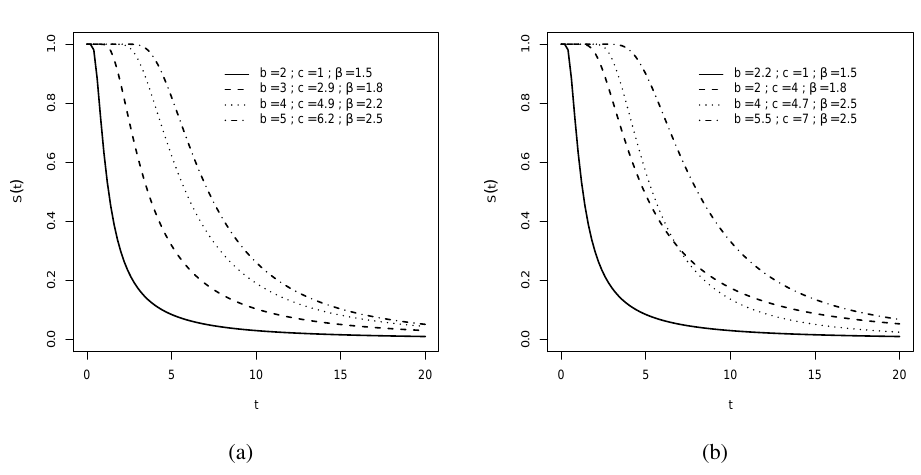
Fig. 2. Kumaraswamy inverse Weibull survival